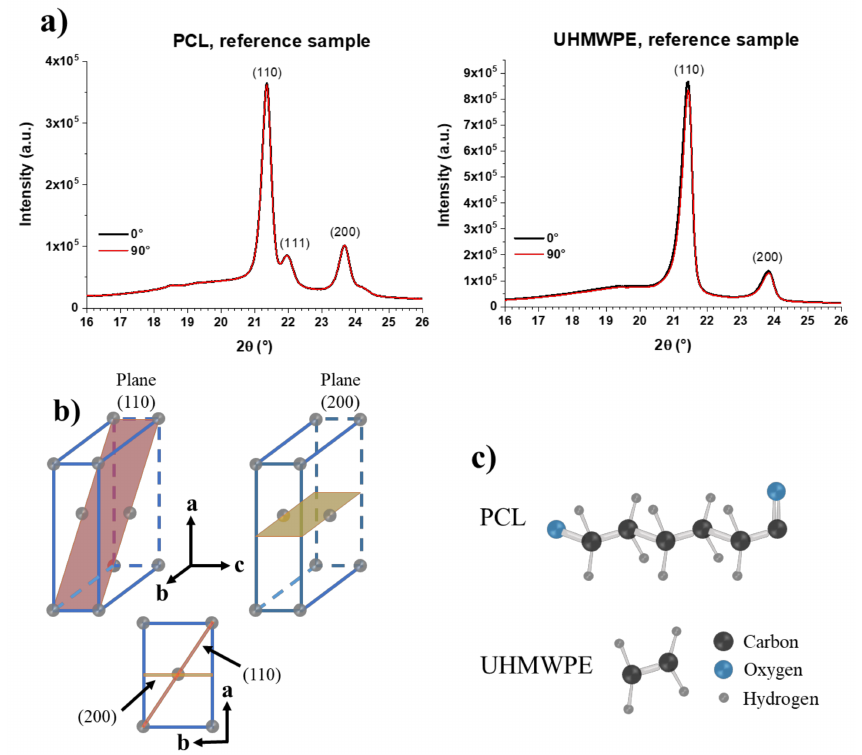
Figure 16. ( a ) XRD patterns of PCL and UHMWPE reference samples, i.e., unformed sheets; ( b ) Schematic representation of planes (110) and (200) of an orthorhombic crystal cell; ( c ) Repeat units of PCL and UHMPWE. A repetitive unit is located in each of the gray points that form the orthorhombic unit cell in ( b